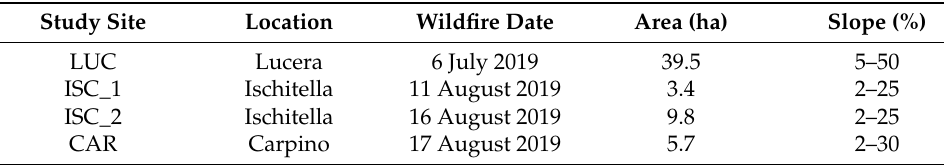
Table 1. Study site